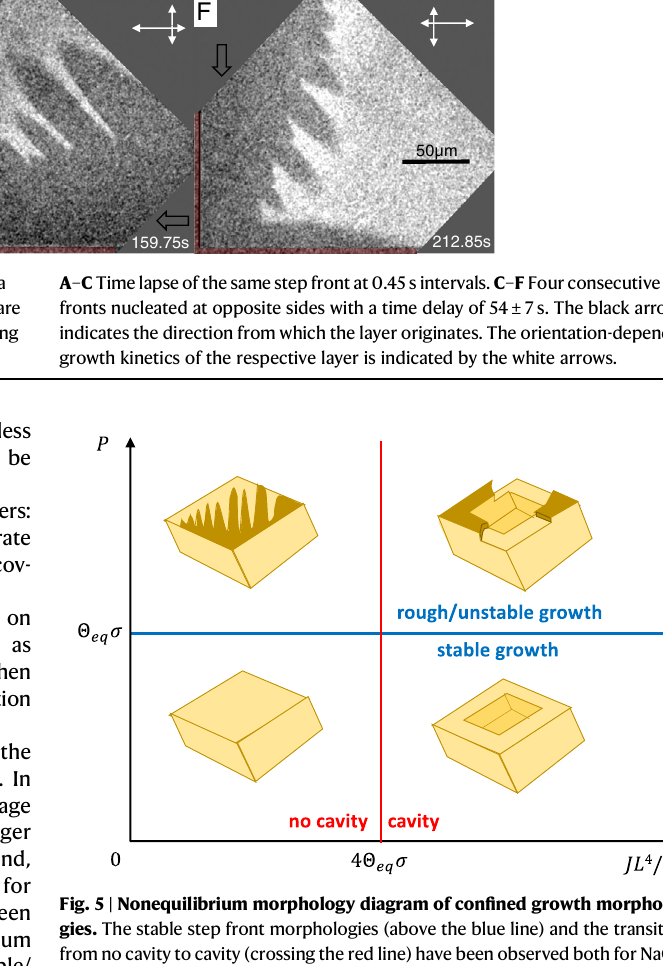
Fig. 5 | Nonequilibrium morphology diagram of con fi ned growth morpholo- gies. The stable step front morphologies (above the blue line) and the transition fromnocavitytocavity(crossingtheredline)havebeenobservedbothforNaClO 3 and CaCO 3 crystals. The fi nger-like instability to the upper left has only been observed on NaClO 3 and the growth rim roughening depicted to the upper right has been observed for both NaClO 3 and CaCO 3 crystals.